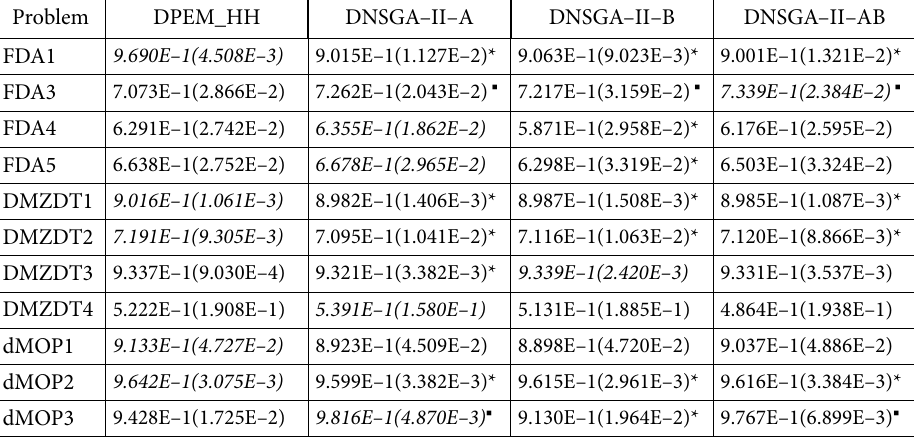
Table 4. Offline mean and standard deviation of HVR metric for DPEM_HH and all DNSGA–II ver-